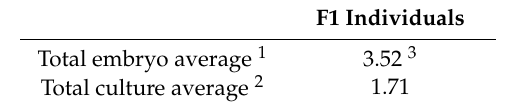
Table 3. The average number of embryos and cultures of the F1